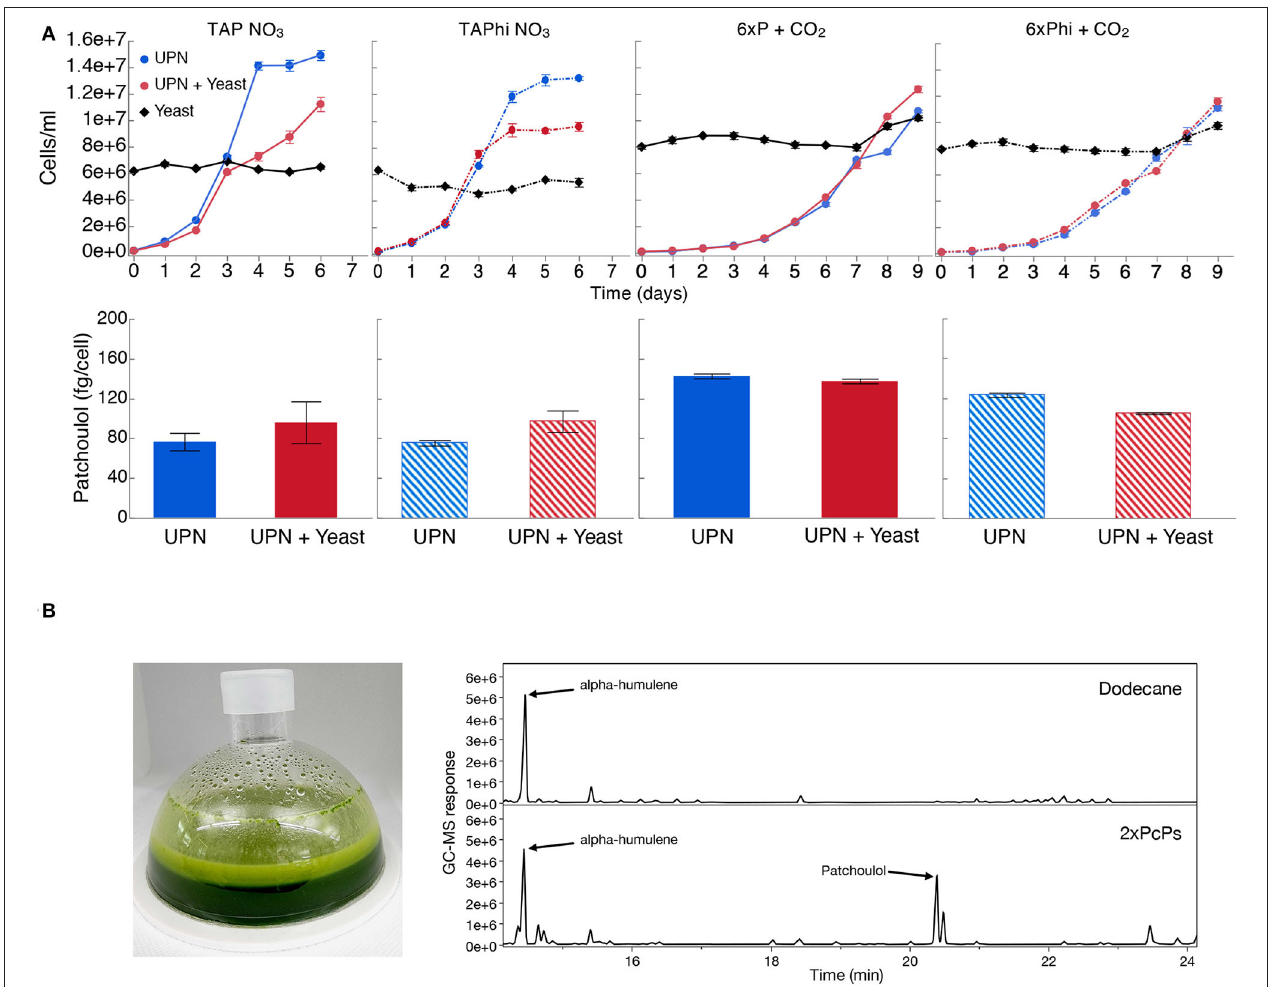
FIGURE 4 | Production of heterologous sesquiterpenoid in the presence of contamination. (A) C. reinhardtii UPN 22 expressing 2X Pc PS-YFP + SQS-amiRNA was cultivated in different trophic modes with and without phosphite and intentionally contaminated with S. cerevisiae cells. TAP-NO 3 and TAPhi-NO 3 were used to compare mixotrophic conditions where acetic acid was a sole carbon source, while 6xP and 6xPhi were used to test photoautotrophic conditions. All growth curves with Phi are represented with dashed lines and hashed bars. The dodecane overlay was used to capture heterologous patchoulol produced. Yeast cells were intentionally inoculated at high densities to challenge the algal cells to outcompete them in these conditions. CO 2 was delivered to autotrophic cultures by placing a high-concentration bicarbonate buffer between microtiter plate wells as an inefficient delivery mechanism to further challenge the algal cells. Patchoulol was quantified on the last cultivation day indicated for each growth curve. Error bars in growth curves represent standard error mean from three biological replicates of three technical replicate samples taken per time point. The error bars in patchoulol quantification are the standard error mean of three technical measurements from pooled dodecane samples across biological replicates. (B) Cultivation of this strain in a 6xPhi medium in an HD100 cultivator (pictured) with the dodecane overlay resulted in efficient patchoulol production from CO 2 . Two GC-MS chromatograms are shown from the 6th day of cultivation, one of the dodecane blanks with an alpha-humulene internal standard and one from algal culture, indicating the peak of produced